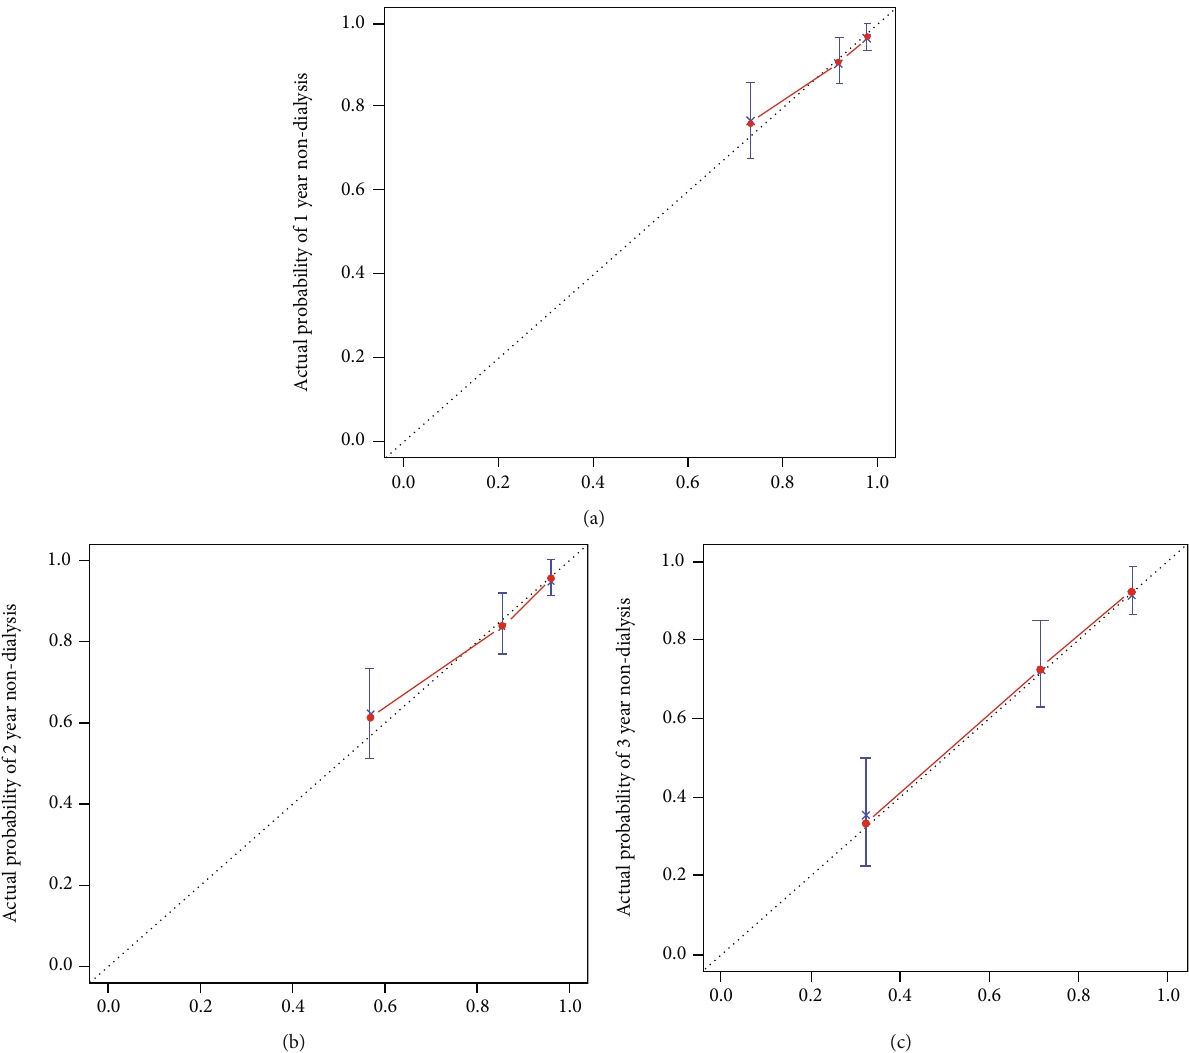
Figure 4: Nomogram-predicted probability of 1 year (a)/2 years (b)/3 years (c) non-dialysis patient